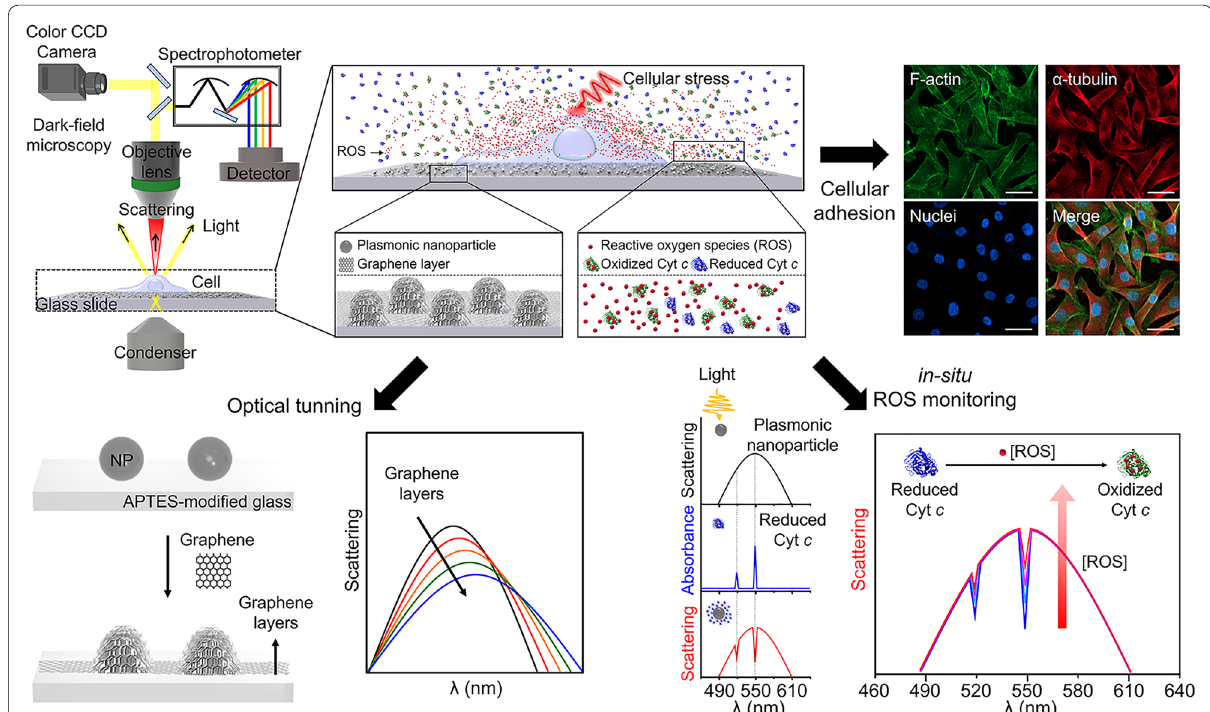
Fig. 1 Overall schematic illustration of ROS monitoring generated from living cells using plasmonic NP-graphene interface. (Upper left) Hyperspectral imaging setup for in-situ monitoring cellular ROS on the graphene-covered plasmonic nanoprobes. (Upper right) Representative images of the cells adhered to the graphene-covered plasmonic nanoprobes. (Lower left) Schematic illustration showing the graphene transfer process on plasmonic nanoparticles pre-immobilized on the APTES-modified glass substrate and optical tunability according to the graphene layers. (Lower right) Principle of ROS monitoring through the measurement of changes in quenching dip at 550 nm for redox-active Cyt